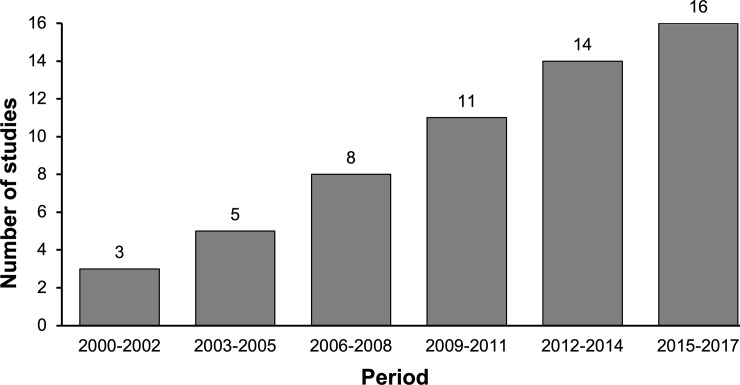
Frequency of stated-preference studies published during three-year periods from 2000 to 2017.